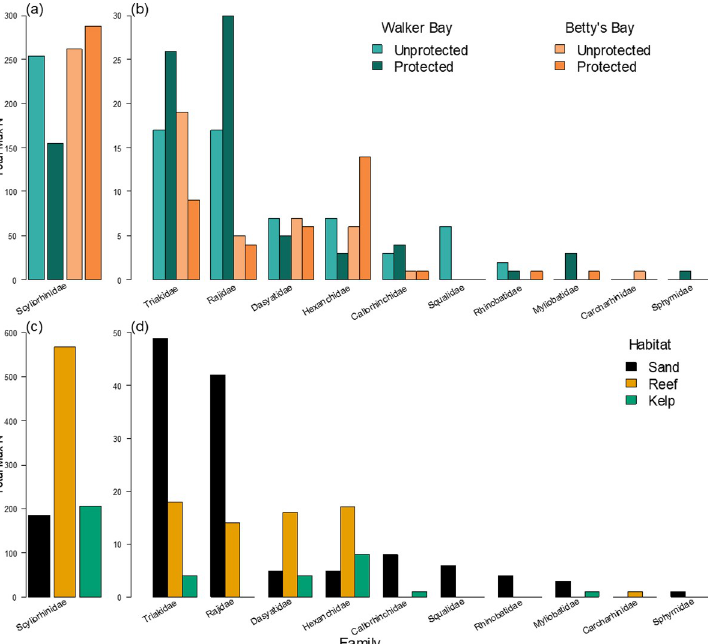
Fig 2. Max N summed for all chondrichthyans species in each family over all BRUVs by (a,b) protection level in each region and (c,d) by habitat. (a, c) The most commonly observed chondrichthyan family, the scyliorhinid catsharks. (b, d) The remaining chondrichthyan families. Note the different scales on the